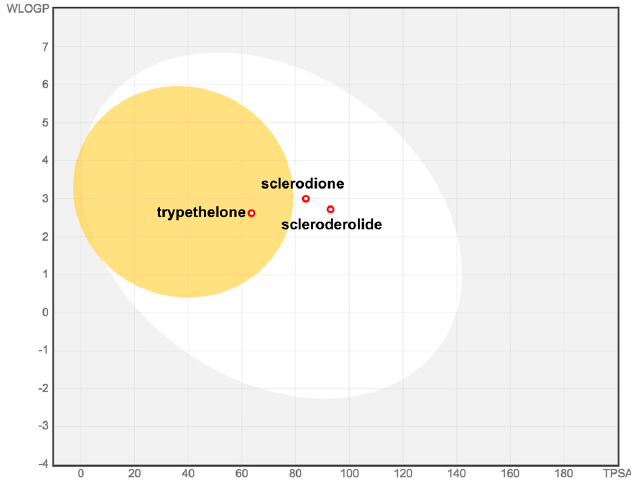
Figure 3. Prediction of gastrointestinal (GI) tract and brain permeation by brain or intestinal estimated permeation predictive model (BOILED-Egg) method. Table 3. Predicted toxicity parameters of compounds 1 – 3 .